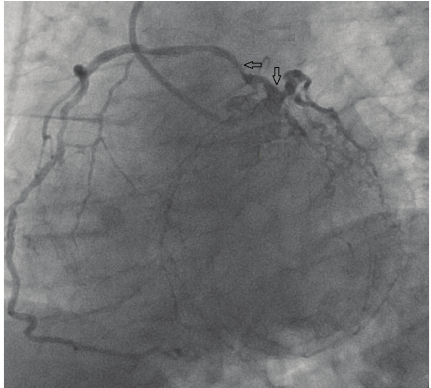
Figure 5: Single coronary ostium and severe ostial lesion of right coronary artery.